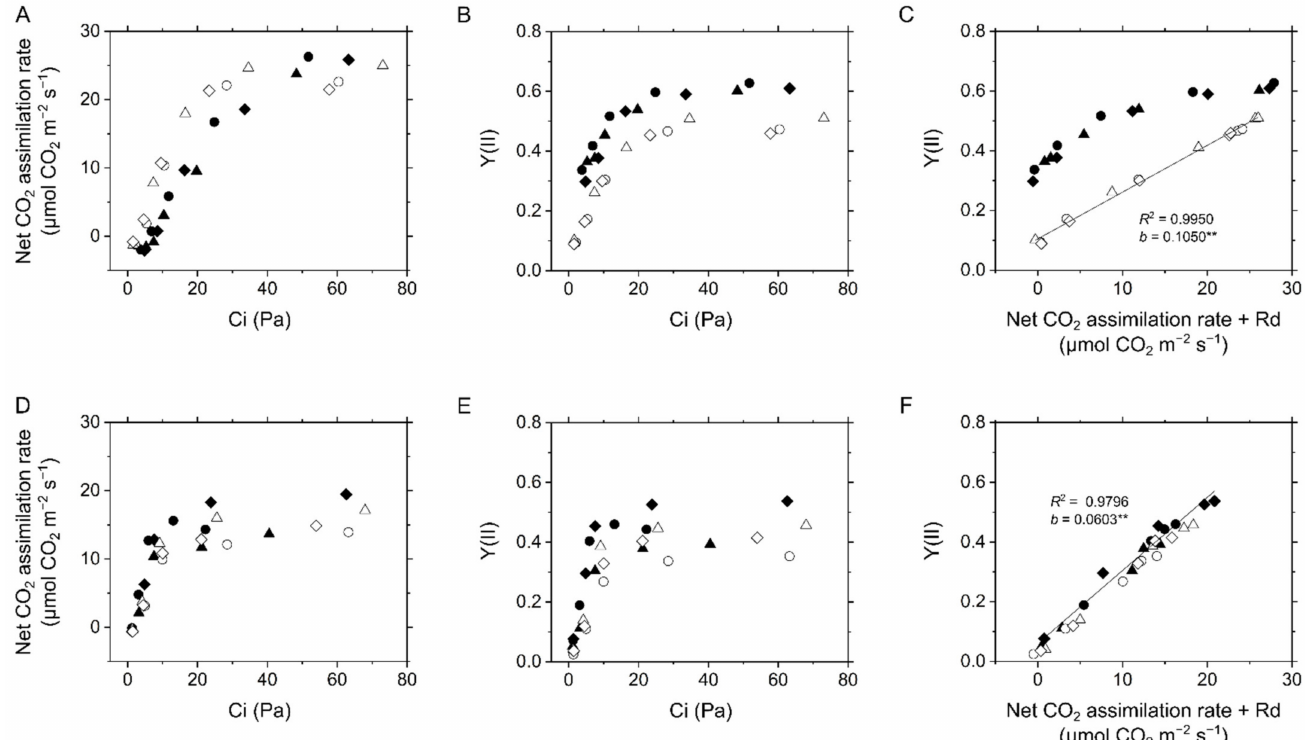
Figure 1. Photosynthetic CO 2 assimilation and linear electron flow in the C 3 plant mustard ( A – C ) and the C 4 plant maize ( D – F ). ( A , D ) Net CO 2 assimilation rate at various intercellular CO 2 partial pressures (Ci). ( B , E ) Effective quantum yield of PSII, Y(II), at various Ci. ( C , F ) Relationship of Y(II) with CO 2 assimilation rate. Dark respiration rate is presented as Rd. Experiments were conducted independently three times as shown in different symbols (biological replicates) at 21 kPa (closed symbols) and 1 kPa O 2 (open symbols). Solid lines represent estimated linear regression of the data at 1 kPa ( C ) and 21 kPa O 2 (F) ( R 2 , coefficient of determination). The y -intercepts ( b ) were tested based on the null hypothesis: ** p <